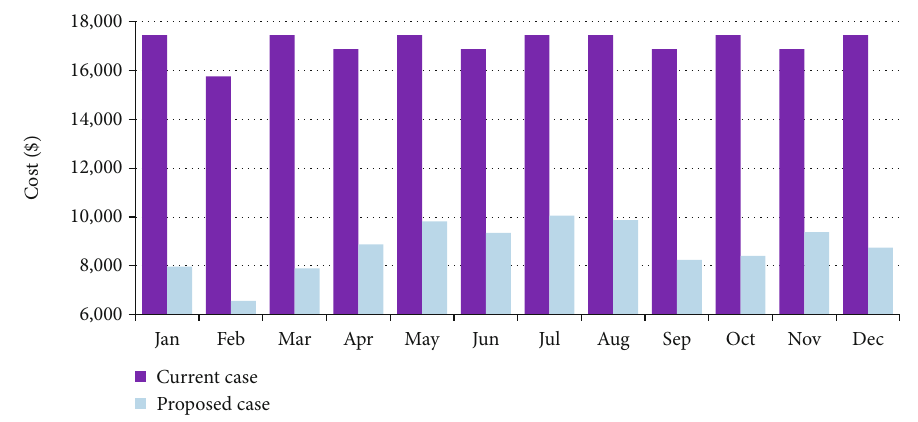
Figure 21: Monthly utility bills for the current and proposed systems for Kenya. Table 7: Annual utility bills and savings by category